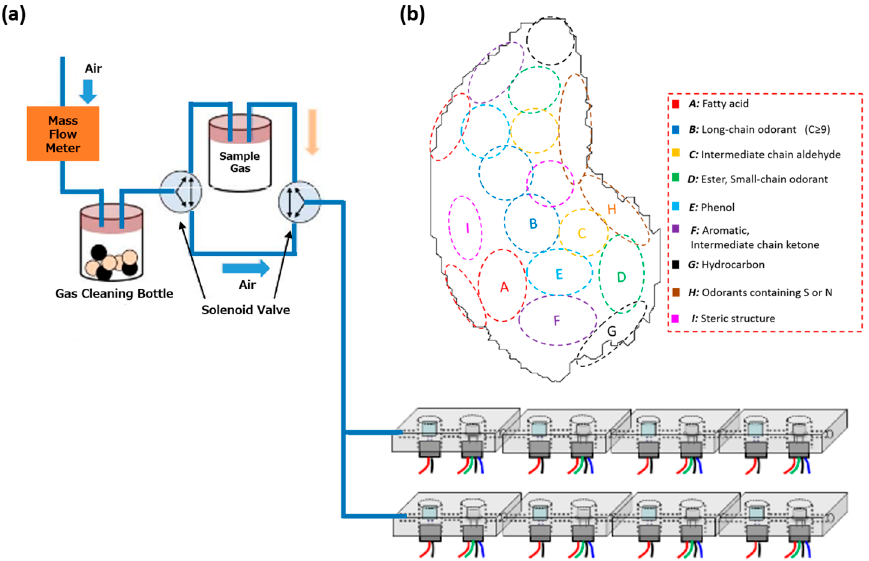
Figure 1. Conceptual approach for a bio-inspired odor sensing system. ( a ) Adsorption-separation odor sensing system; ( b ) Resulting odor cluster map for odor evaluation [13].